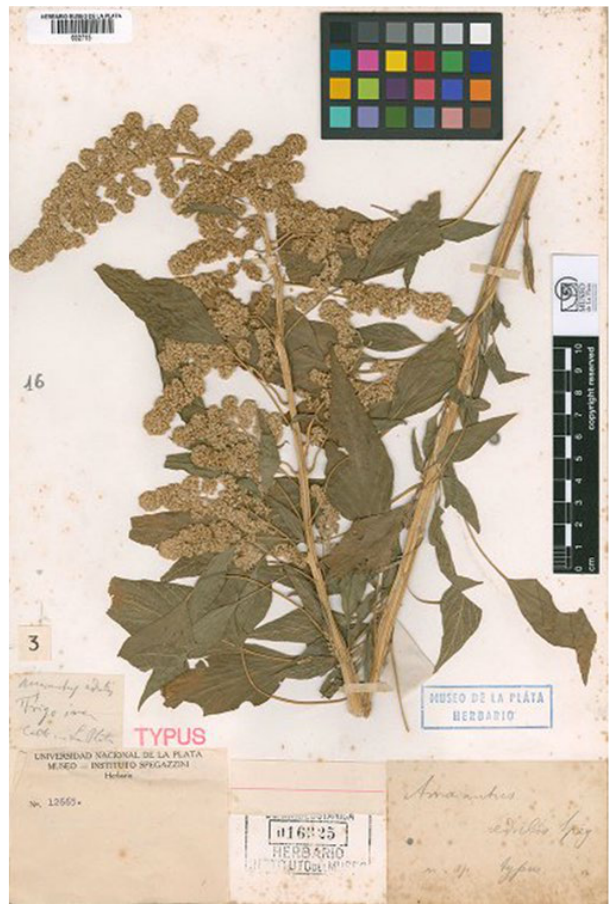
Figure 7. Lectotype of the name Amaranthus edulis var. edulis (LP002715 (image!)).